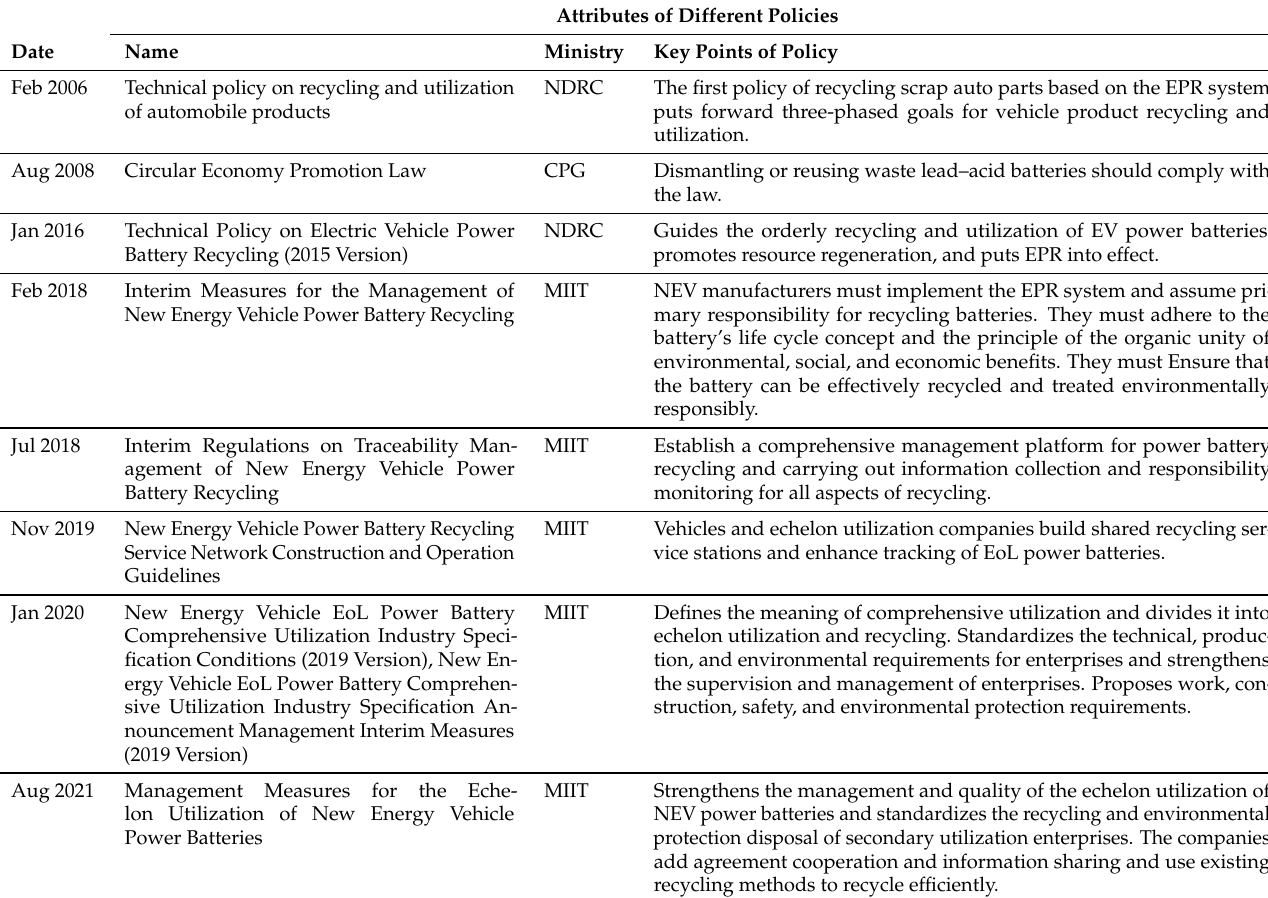
Table 4. Laws and regulations on EoL power battery recycling in